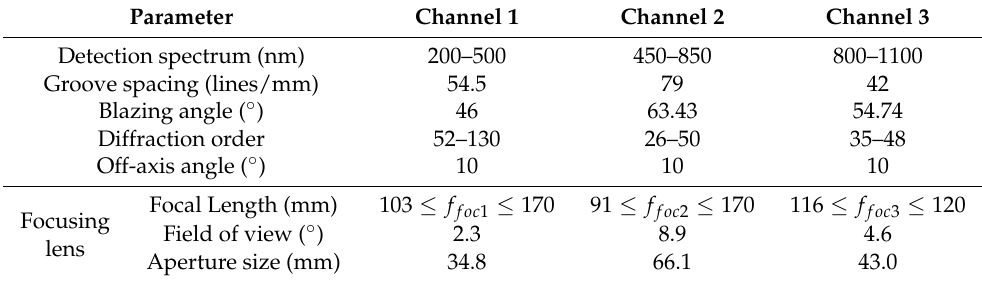
Table 3. Parameters of the echelle